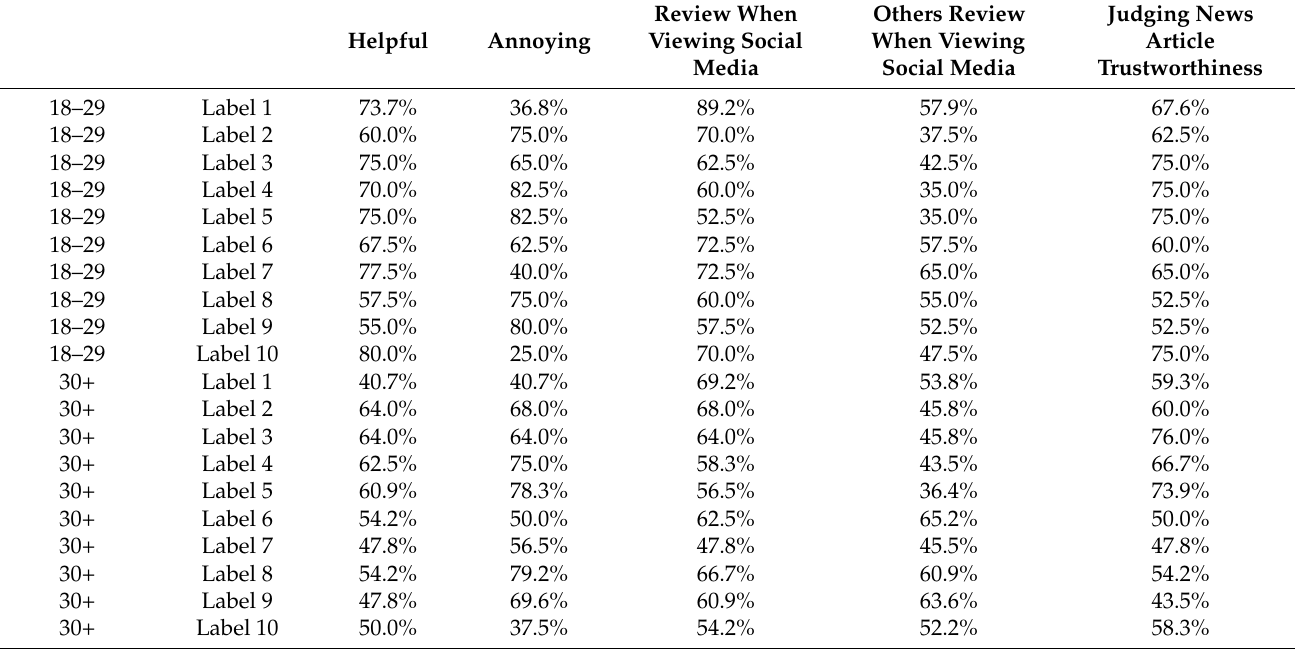
Table 9. Results of survey 2 by label and by age